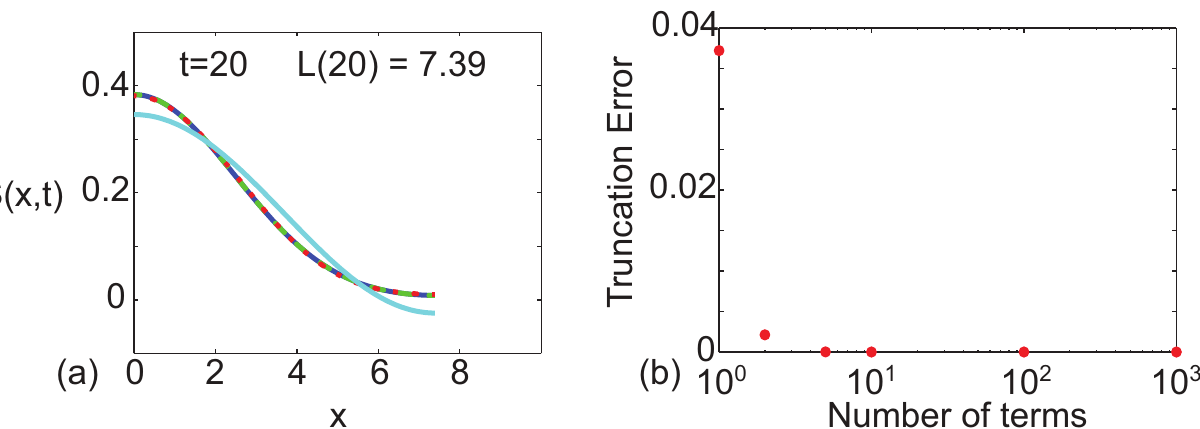
P 4 C ð x ; t Þ . i i ¼ 1